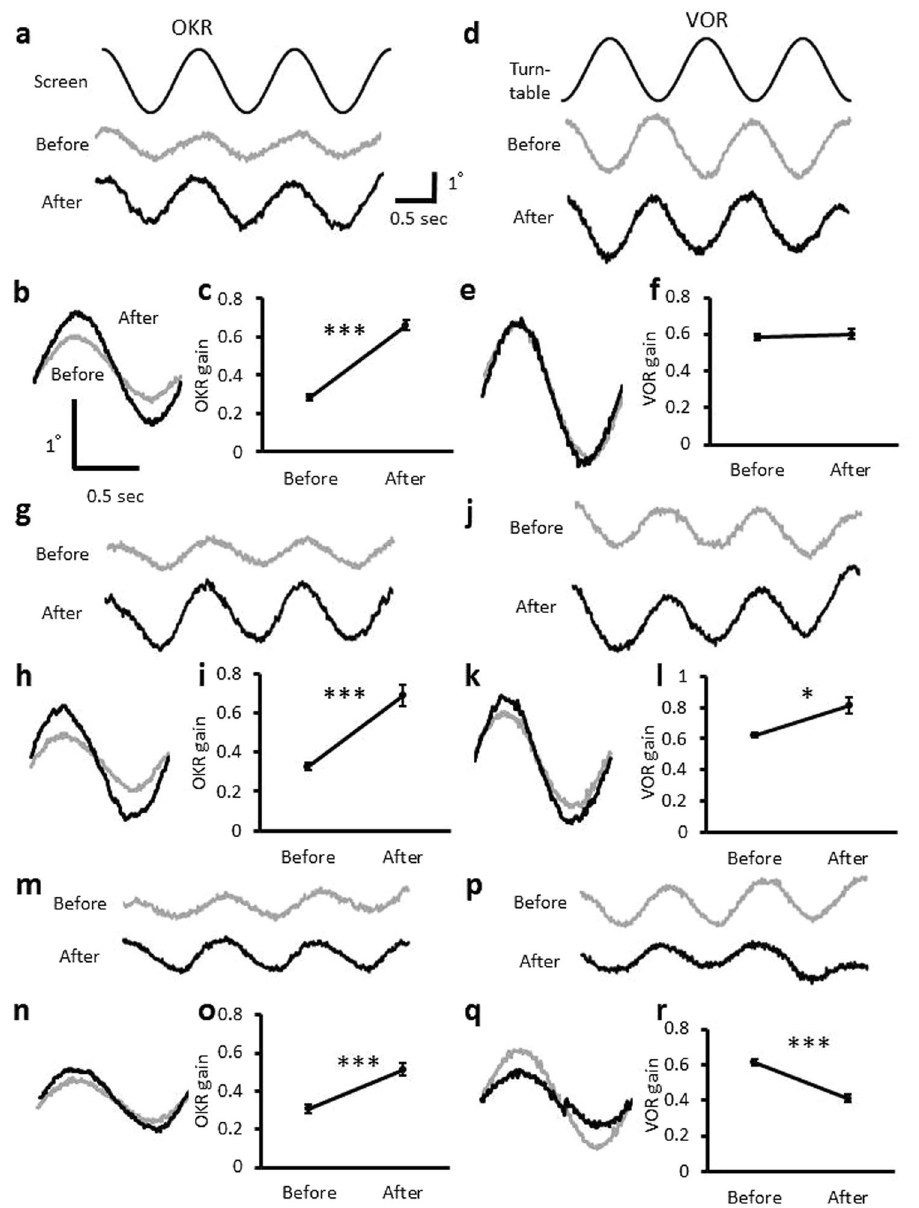
Figure 4. Effects of OKR, gain-up or gain-down VOR training. ( a ) Eye movement traces during OKR before and after OKR training presented with the command signal corresponding to the screen position. ( b ) Averaged (10 cycles) traces of eye position during OKR before (grey) and after (black) OKR training. ( c ) OKR gain change by OKR training. ( d ) Eye movement traces during VOR before and after OKR training presented with the command signal corresponding to the turntable position. ( e ) Averaged traces of eye position during VOR. ( f ) VOR gain change by OKR training. ( g ) Eye movement traces during OKR before and after gain-up VOR training. ( h ) Averaged traces of eye position during OKR. ( i ) OKR gain change by gain-up VOR training. ( j ) Eye movement traces during VOR before and after gain-up VOR training. ( k ) Averaged traces of eye position during VOR. ( l ) VOR gain change by gain-up VOR training. ( m ) Eye movement traces during OKR before and after gain-down VOR training. ( n ) Averaged traces of eye position during OKR. ( o ) OKR gain change by gain-down VOR training. ( p ) Eye movement traces during VOR before and after gain-down VOR training. ( q ) Averaged traces of eye position during VOR. ( r ) VOR gain change by gain-down VOR training. Error bars indicate SEM. * p < 0.05, *** p < 0.001, paired Student’s